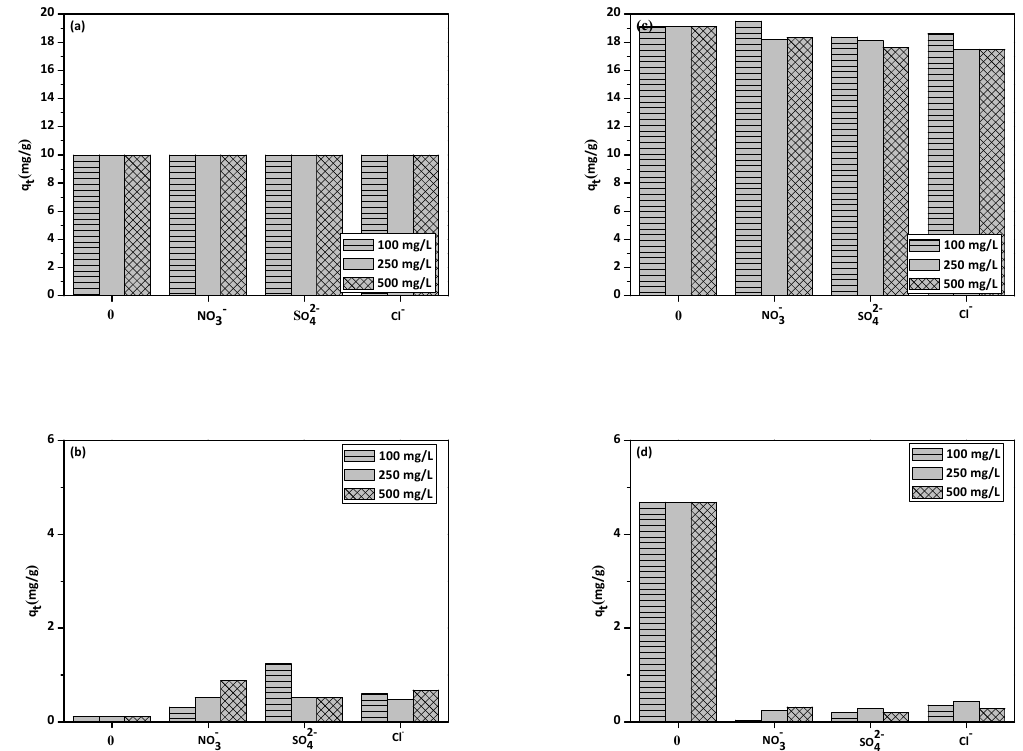
Figure 9. Effect of interfering ions on sorption capacity of ( a ) Cu(II), ( b ) phenol on NaP1, ( c ) Cu(II), and ( d ) phenol on NaP1CS (100, 250, 500 mg/L of NO 3 − , Cl − , SO 42 − , C 0 = 50 mg/L phenol–50 mg/L Cu(II), m = 0.1g, t = 120 min).